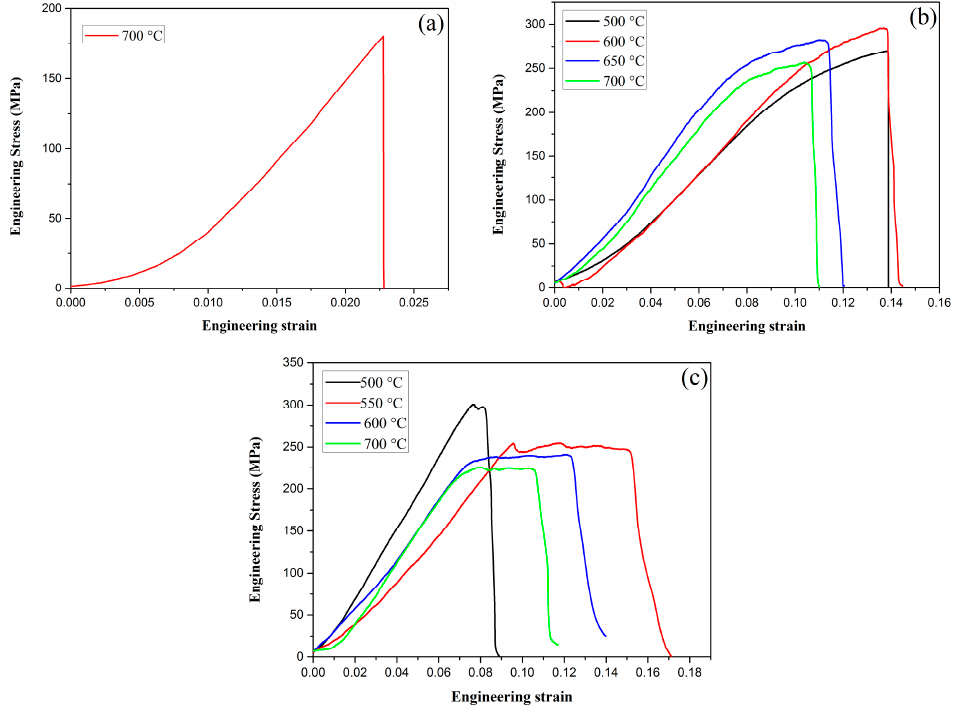
Figure 8. Tensile behaviors for ( a ) pure W; ( b ) W–1 wt % Nd 2 O 3 ; ( c ) W–1 wt % CeO 2 .